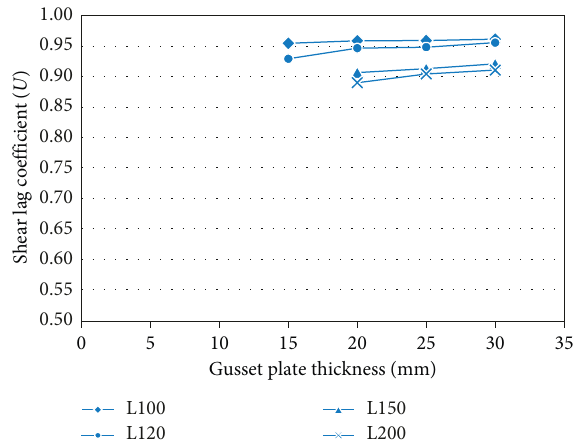
Figure 12: Effect of gusset plate thickness on the tension capacity of double angles.